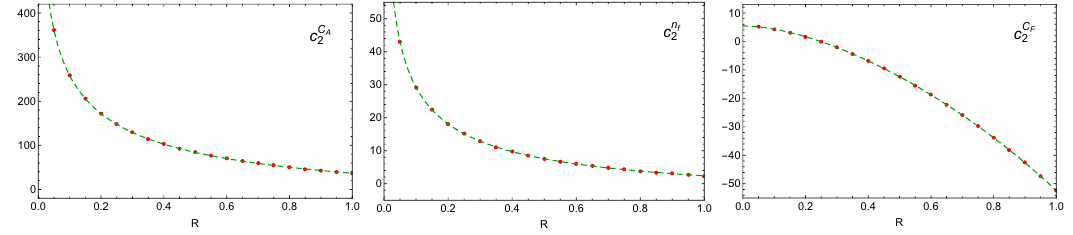
Figure 3. The same as in (cid:12)gure 2 for the (cid:12)nite term of the renormalised beam-thrust jet-veto soft